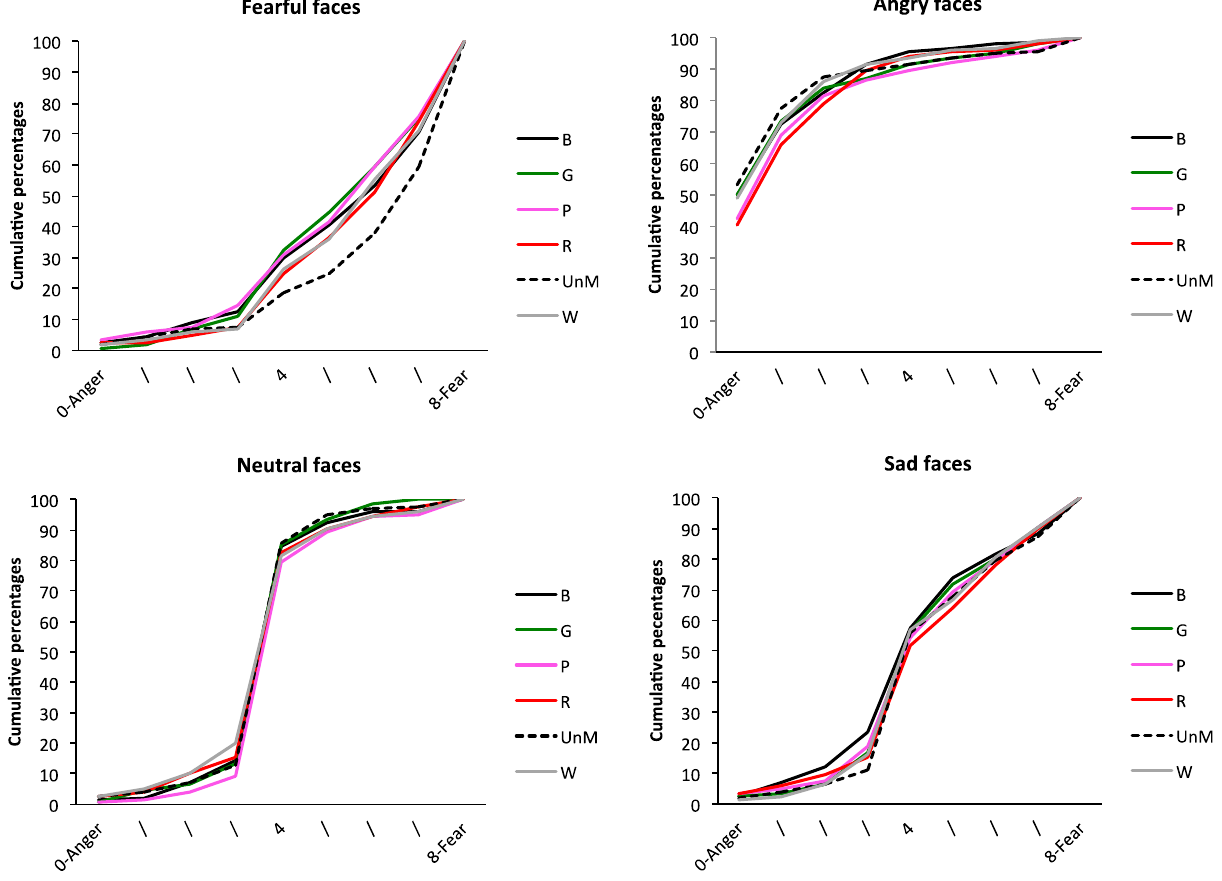
Figure 3. Cumulative percentages of the perception of each EFE for Scale 1, as a function of mask condition (faces wearing a B black, G green, P pink, R red, W white, mask ; UnM unmasked